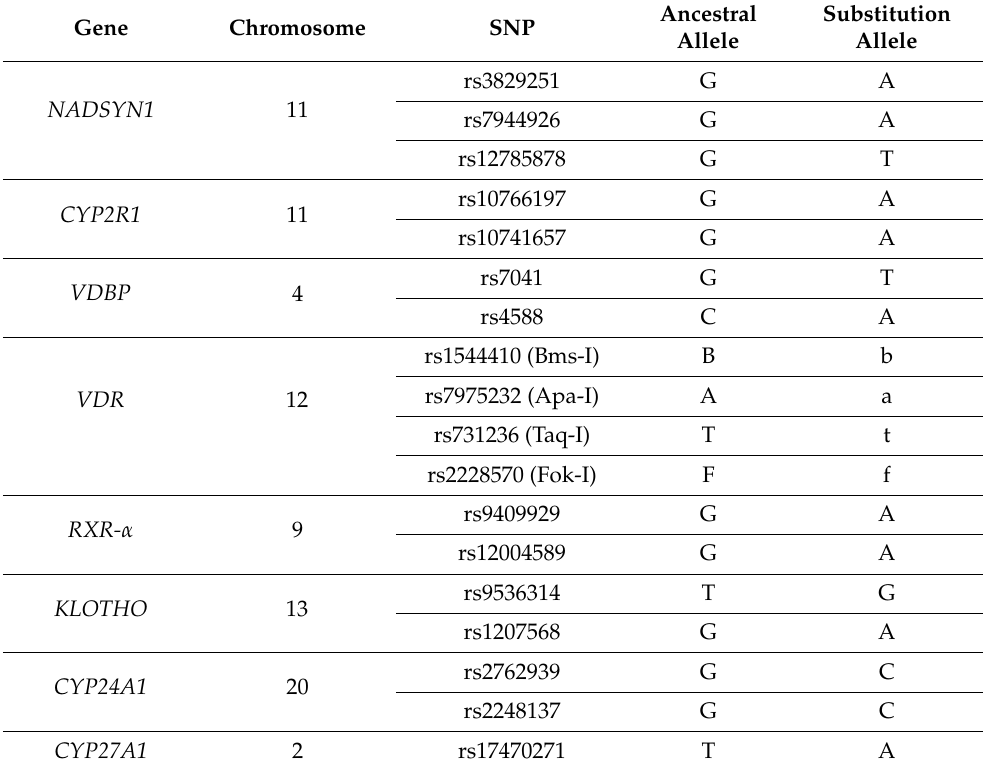
Table 1. Characteristics of vitamin D-related